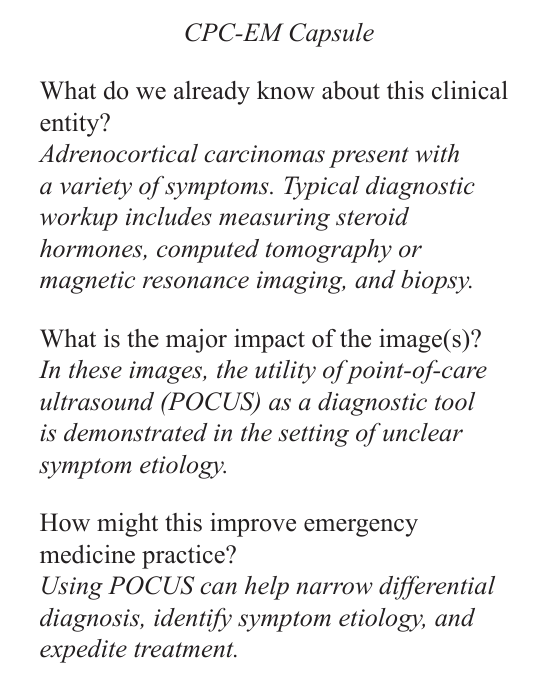
Video. Right upper quadrant mass. Ultrasound transducer held in the posterior axillary line demonstrating a circular mass with an anechoic center (arrow) as the beam fans from anterior to